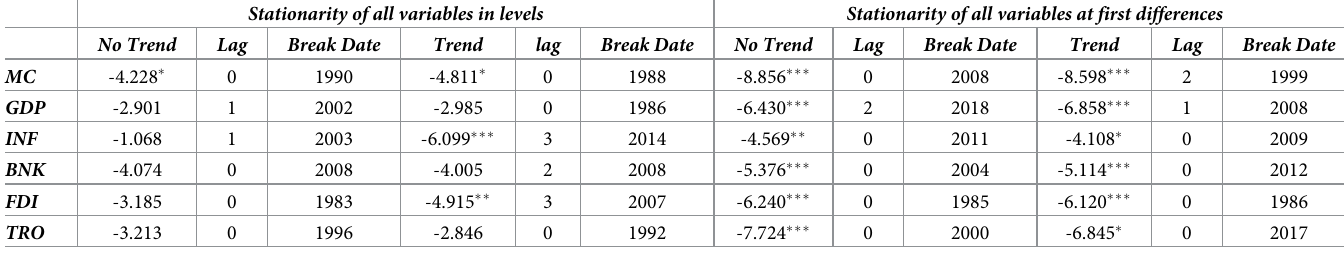
Table 3. Zivot-Andrews unit root test of variables in level and at the first difference. Stationarity of all variables in